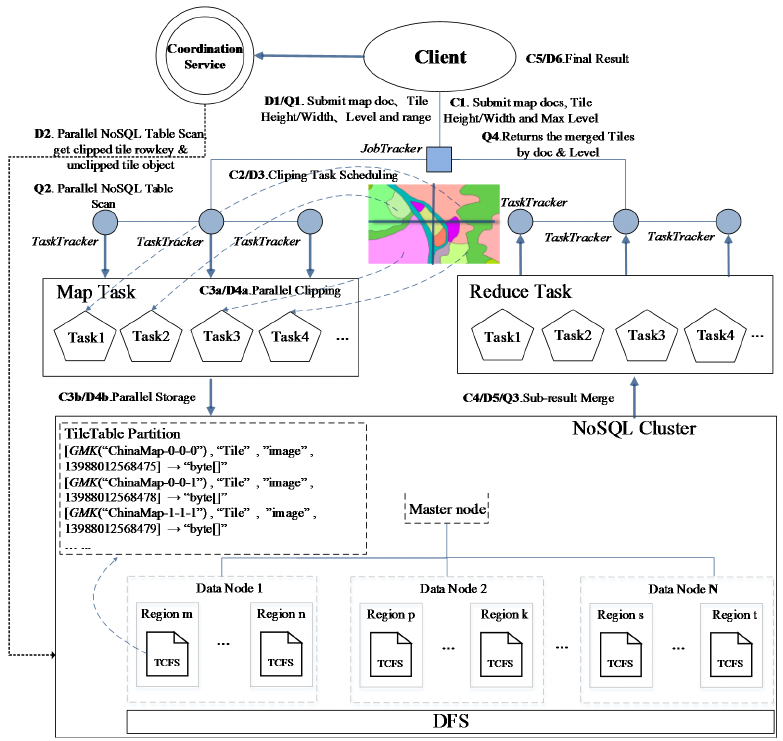
Figure 9. MapReduce-based tile map parallel processing framework.